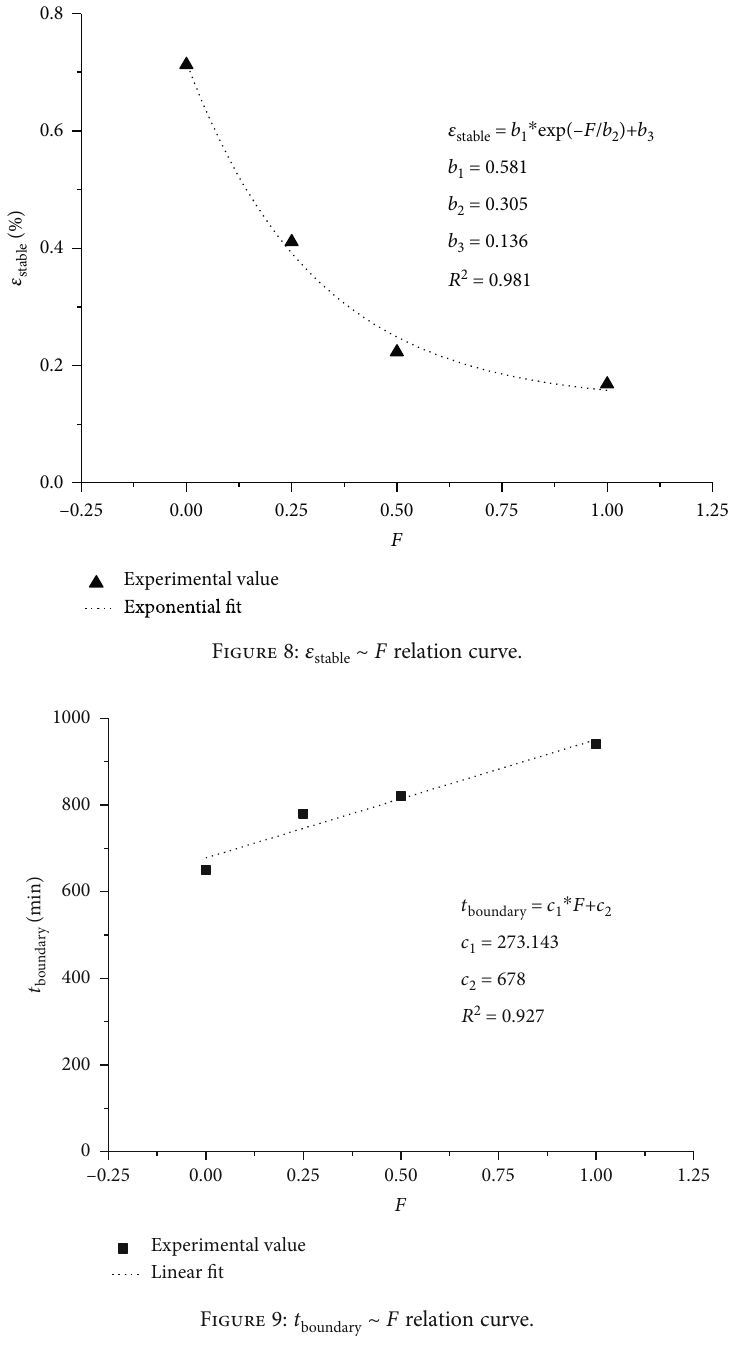
Figure 9: t ~ F relation boundary